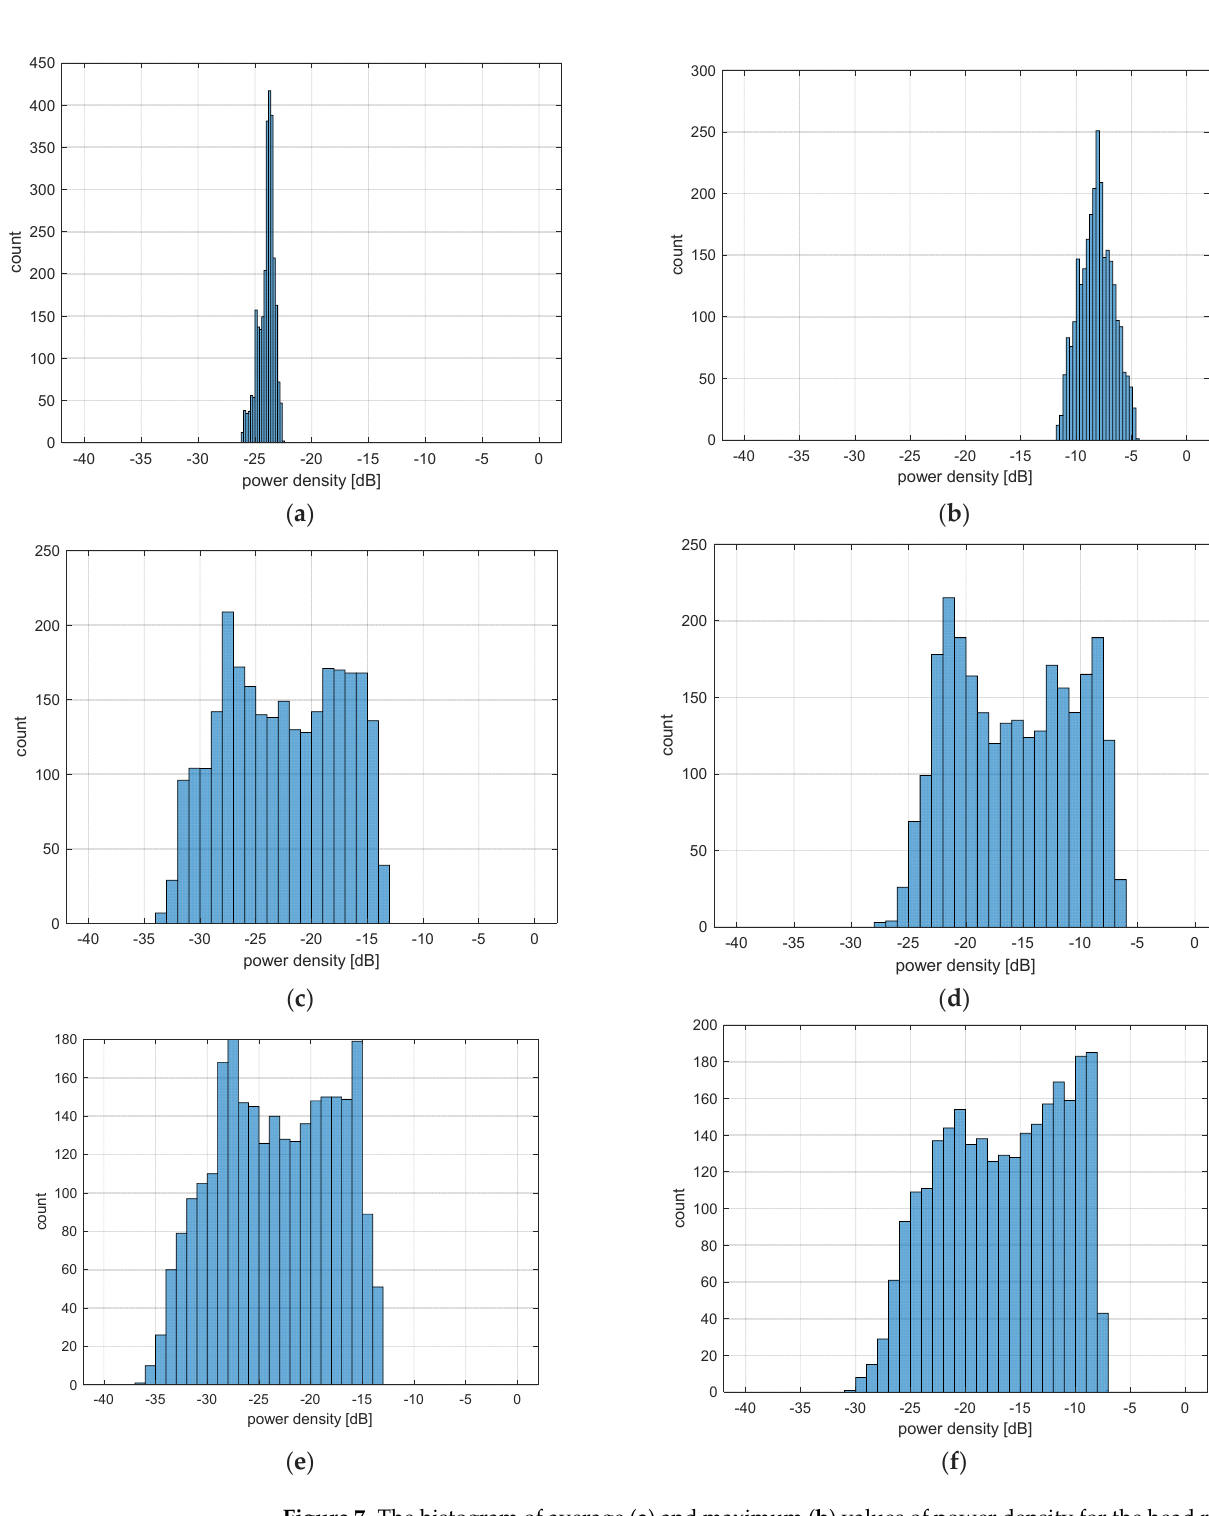
occurrence. For the right eye, the most common peak is − 8.5 dB, and values from − 25 to − 8 dB are common in the results.